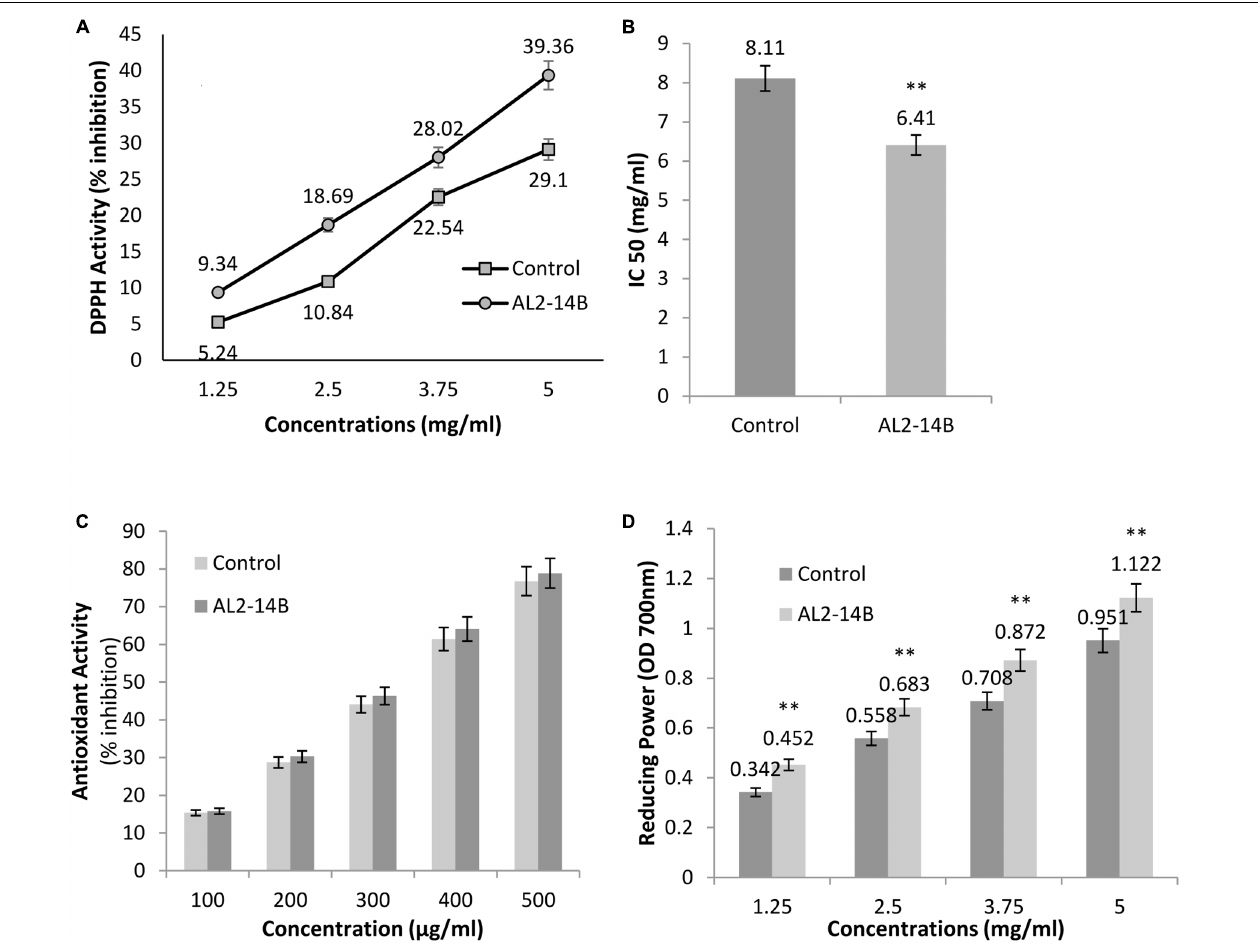
FIGURE 6 | (A) The free radical scavenging activity with DPPH, against different concentrations of A. aspera L. extract; (B) concentration of samples that scavenge 50% free radicals of DPPH, expressed as IC 50 (mg/mL); (C) antioxidant activity of samples using β -carotene bleaching assay; and (D) reducing power of samples at 700 nm. All results are expressed as mean ± SD of three determinations. ∗∗ Significant at P <